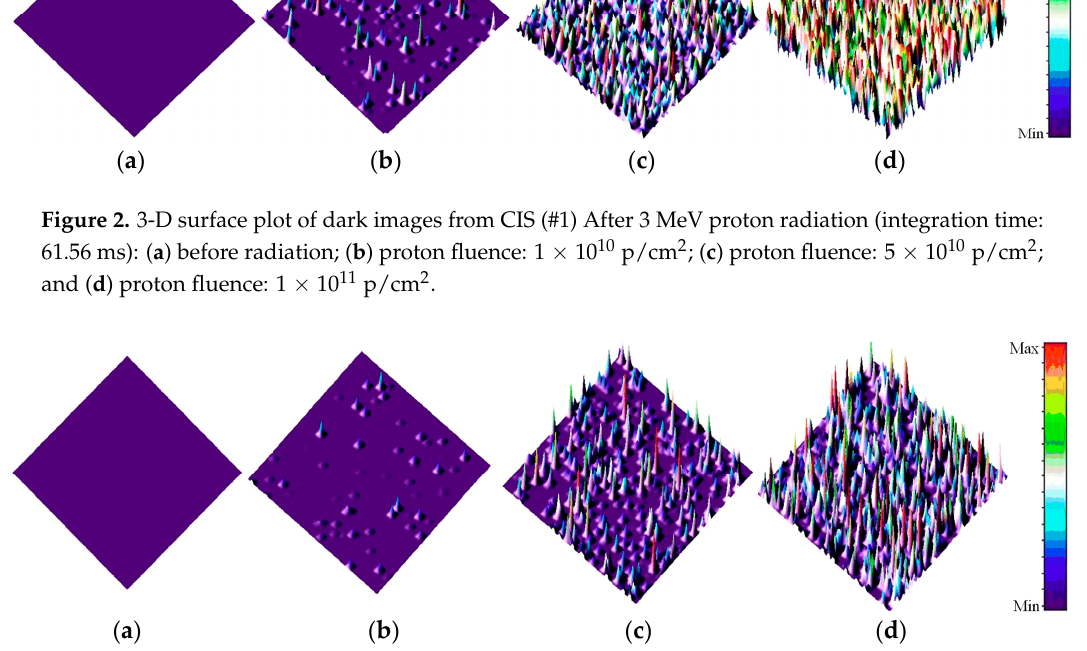
Figure 3. 3-D surface plot of dark images from CIS (#1) After 10 MeV proton radiation (integration time: 61.56 ms): ( a ) before radiation; ( b ) proton fluence: 1 × 10 10 p/cm 2 ; ( c ) proton fluence: 5 × 10 10 p/cm 2 ; and ( d ) proton fluence: 1 × 10 11 p/cm 2 .